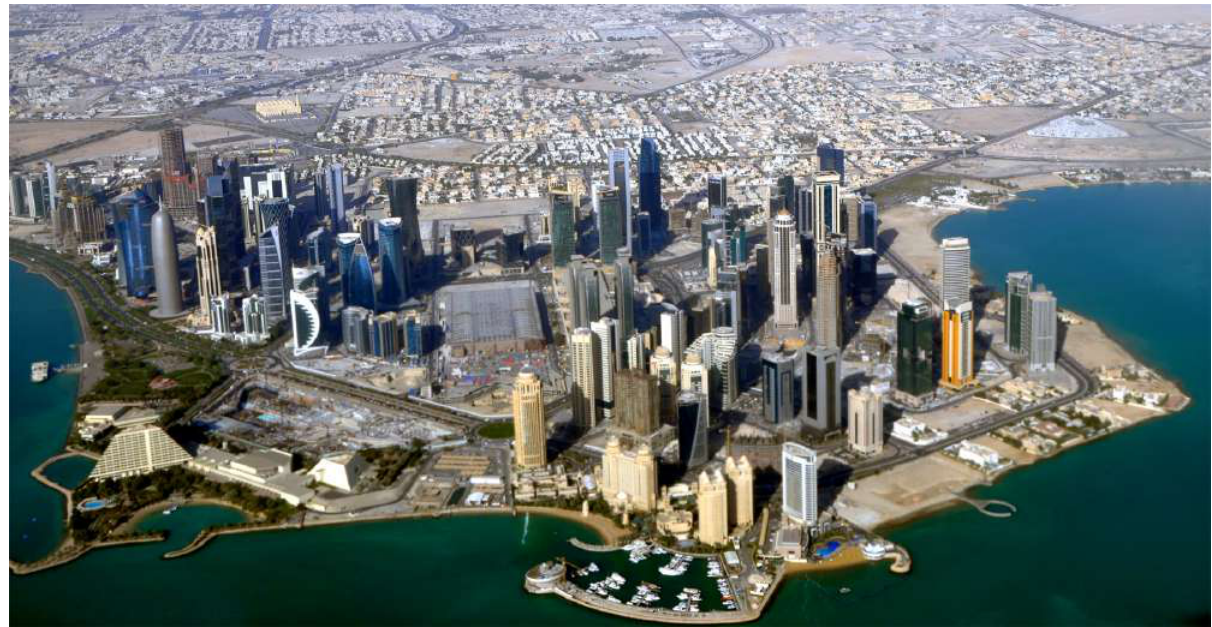
Fig. 4 Aerial photograph of West Bay (Source: Peter